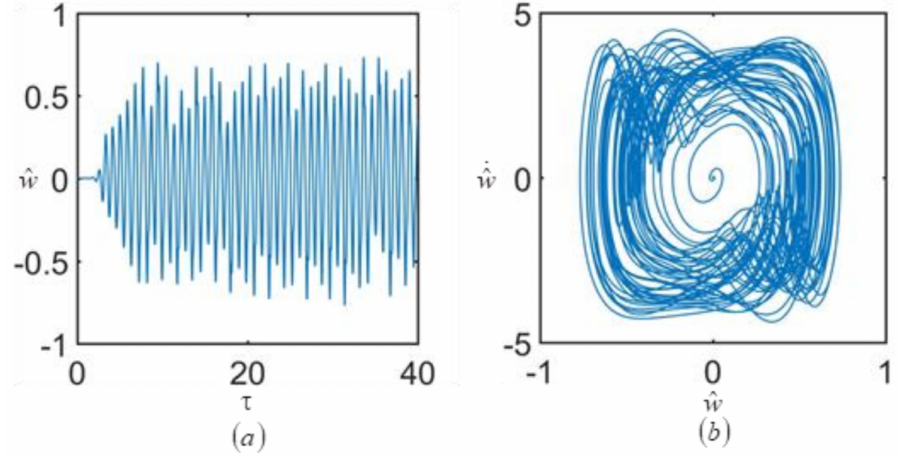
Figure 14. The nonlinear response for the CFRP laminated cylindrical shell with an excitation frequency in the stable region: ( a ) the time history on the plane ( τ , ˆ w ) , and ( b ) the phase portrait on . ˆ w ) the plane ( ˆ w ,